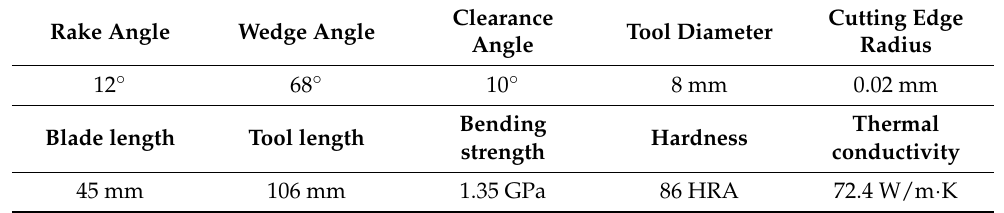
Table 2. Tool geometries and properties of cutting